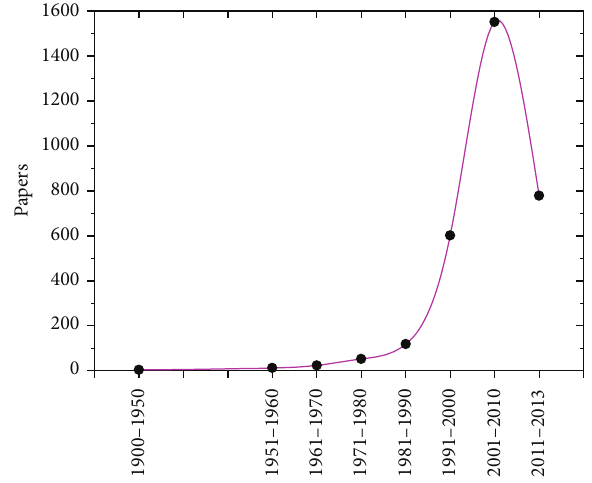
Figure 1: Works published for “molecular imprinted polymers” term (data after search in